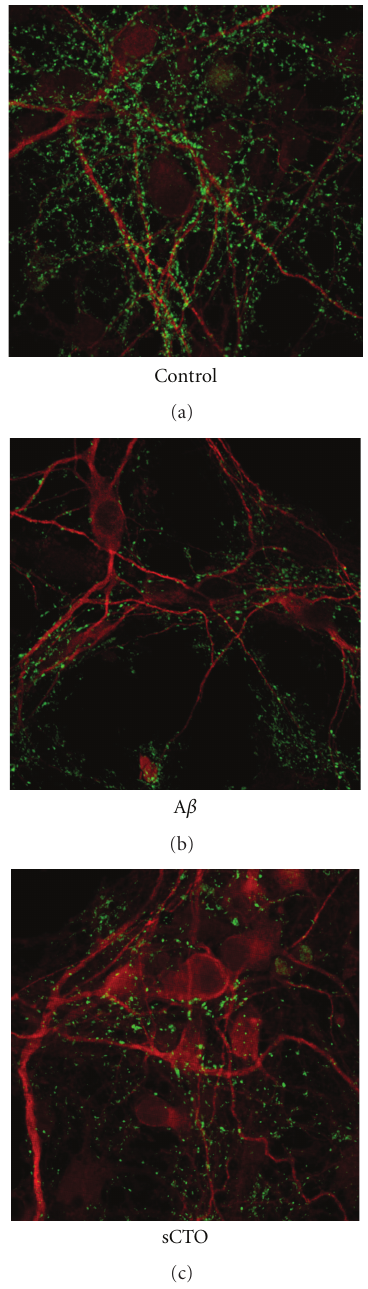
Figure 5: sCTOs and A β oligomers similarly damage the neuritic tree and synapses in mature hippocampal neurons. After sCTO or A β treatments, the extension of the dendritic tree, immunolabeled for microtubule-associated protein 2 (red fluorescence), is evidently reduced, while the number of synapses, immunolabeled for synap- tophysin (green fluorescence), is